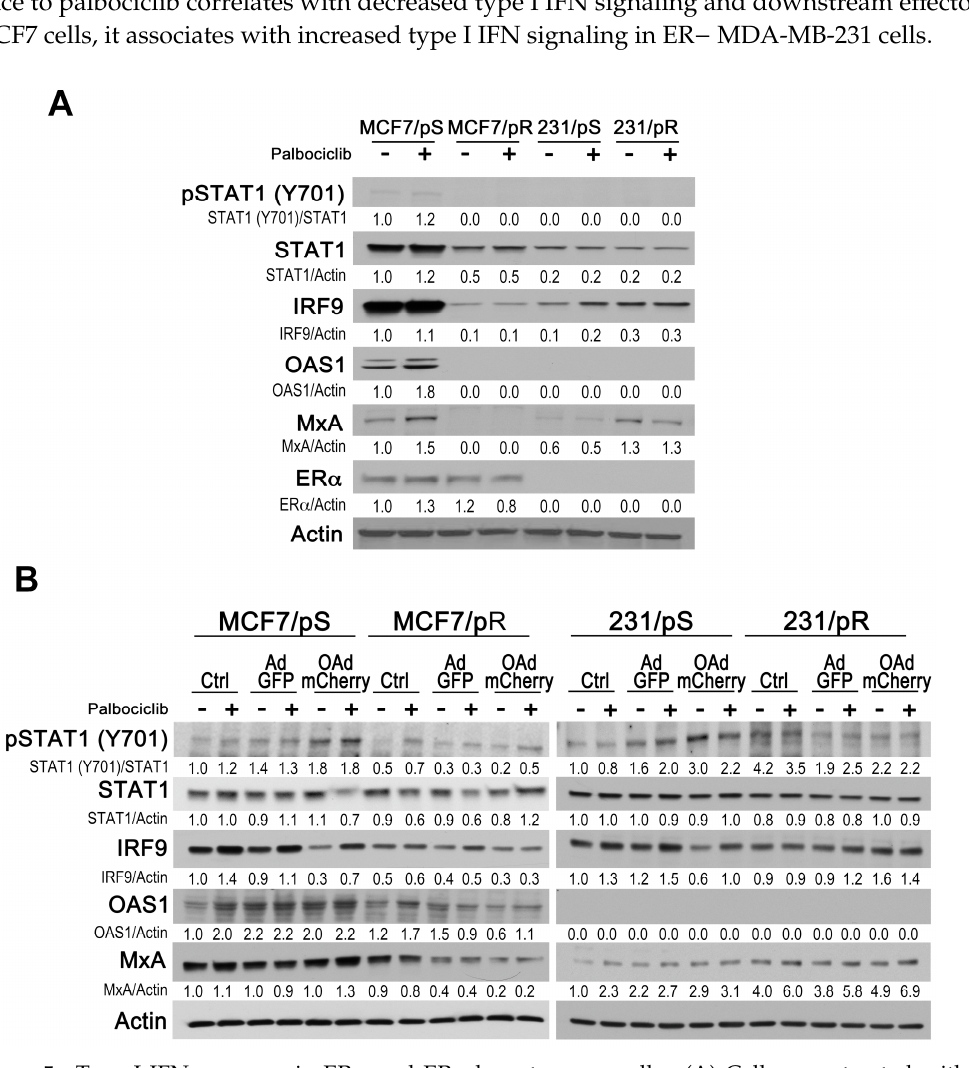
Figure 5. Type I IFN response in ER + and ER − breast cancer cells. ( A ) Cells were treated with either the vehicle (H 2 O) or palbociclib (500 nM), harvested after 24 h, and immunoblotted with the indicated antibodies. ( B ) Cells were either left uninfected (Ctrl) or infected with AdGFP or OAdmCherry at a multiplicity of infection ( MOI) concentration of five alone or in combination with 500 nM